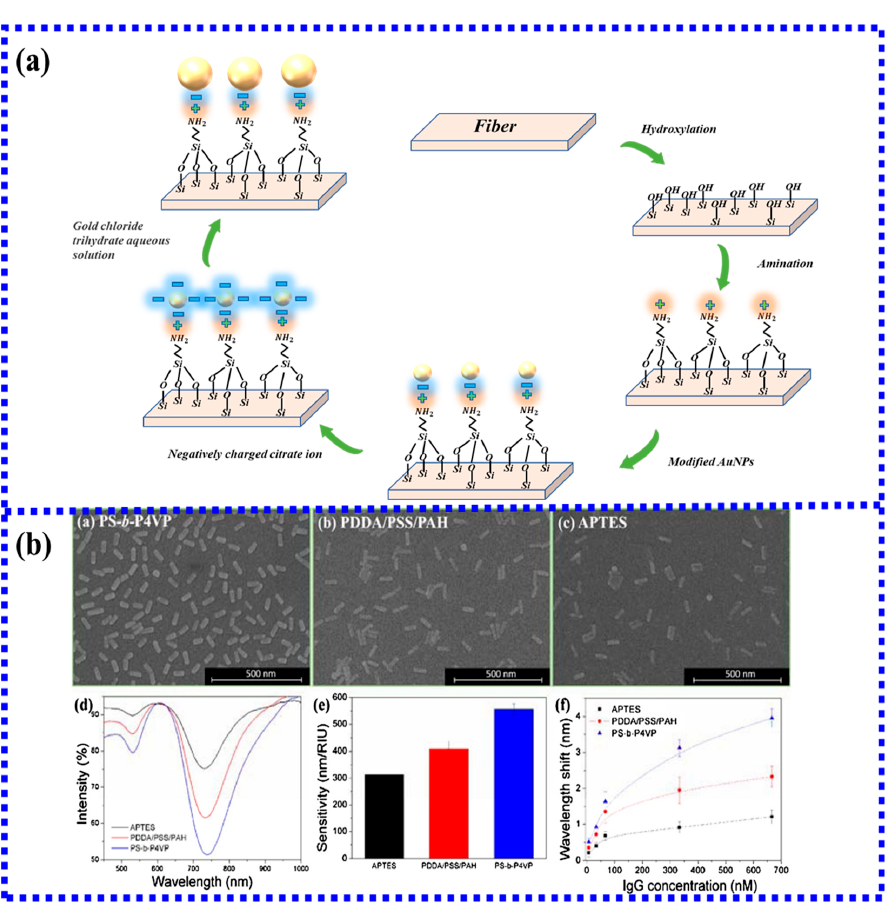
Figure 4. ( a ) The method of increasing the volume of gold nanoparticles by the secondary immersion in citrate; ( b ) Comparison of the BCP method with traditional electrostatic self-assembly and silane method [48]. Copyright 2023, Elsevier.